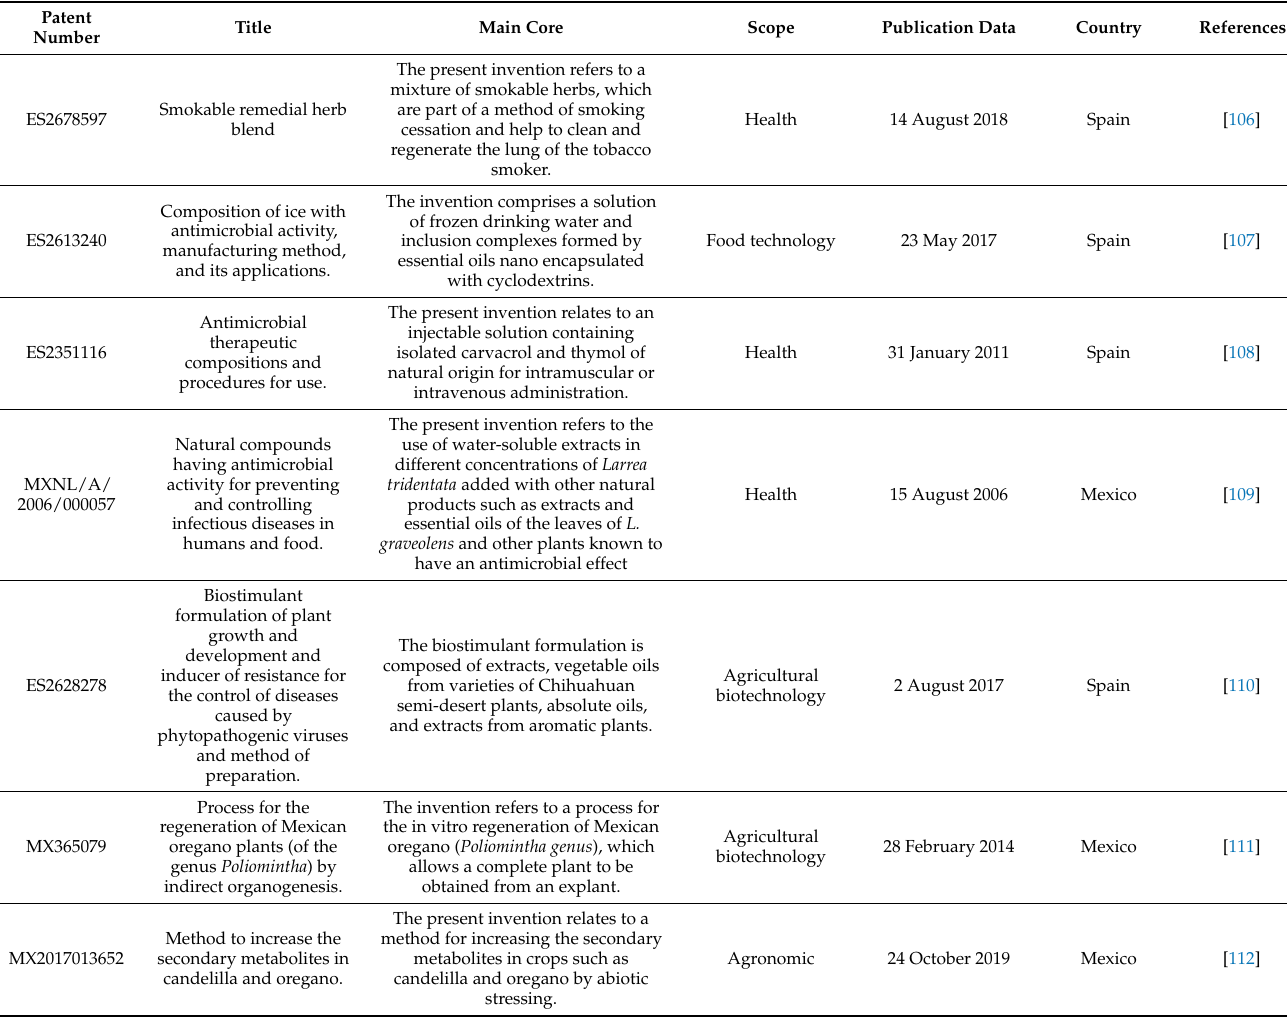
Table 3. Reported patents in Google Patents and WIPO-PATENTSCOPE databases related with industrial application of oregano and Mexican oregano ( L. graveolens